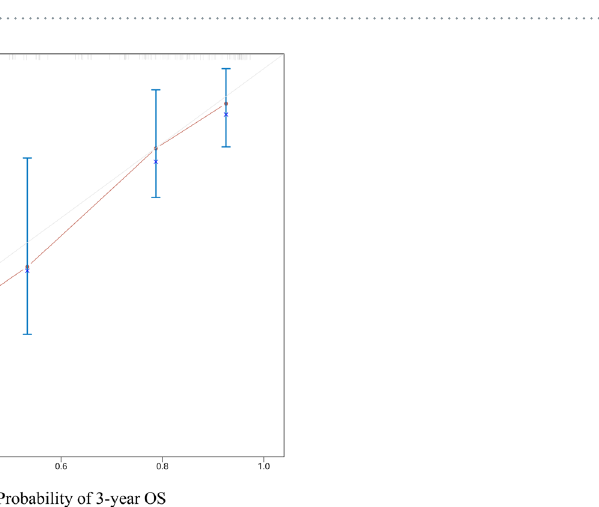
Figure 3. Nomogram for the prediction of 3-year overall survival after TURP in metastatic prostate cancer patients.